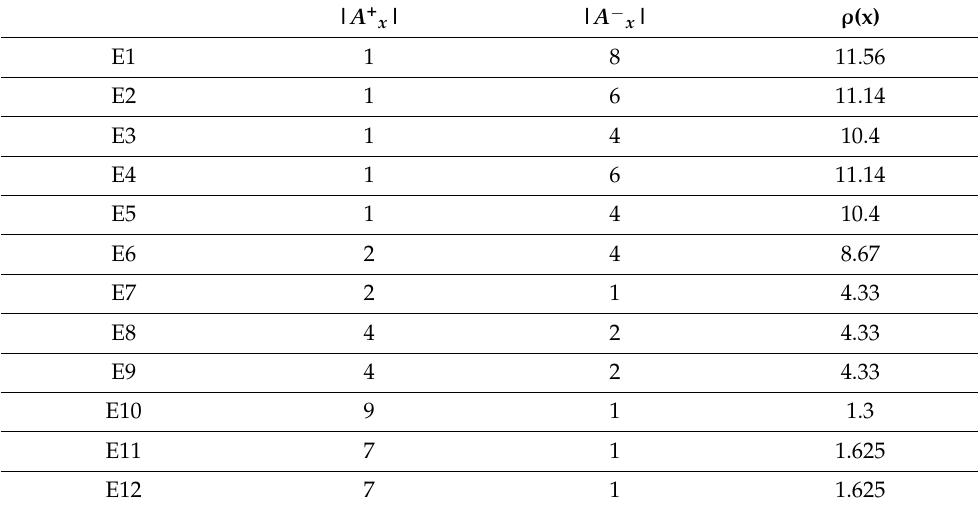
Table 8. The results of events